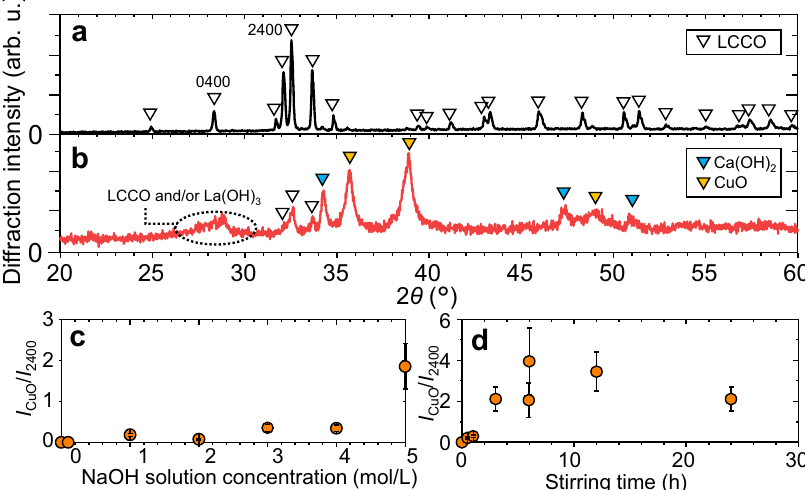
Fig. 5 XRD patterns. a Polycrystalline LCCO. Two miller indices are indicated as hkl L l C , where the subscripts, L and C, denote spin ladder and chain, respectively 34 . b The fi lter residues subjected to immersion to NaOH aqueous solution with 5 mol/L concentration at a 6 h stirring time. Dependences of the decomposition rate on c NaOH solution concentration at a 6 h stirring time and d stirring time for 5 mol/L